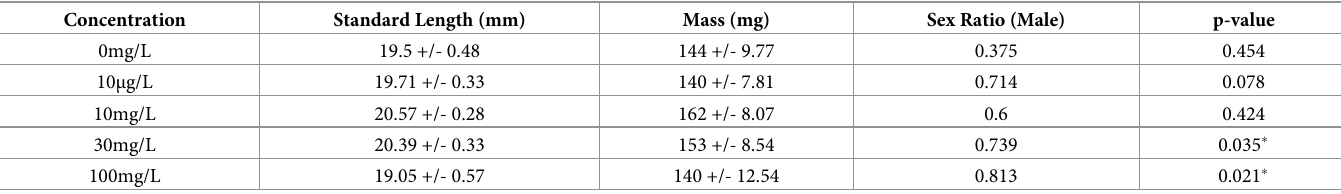
The p-value derives from a binomial test comparing the frequency of males to 0.5. Asterisk denotes a significantly higher proportion of males than